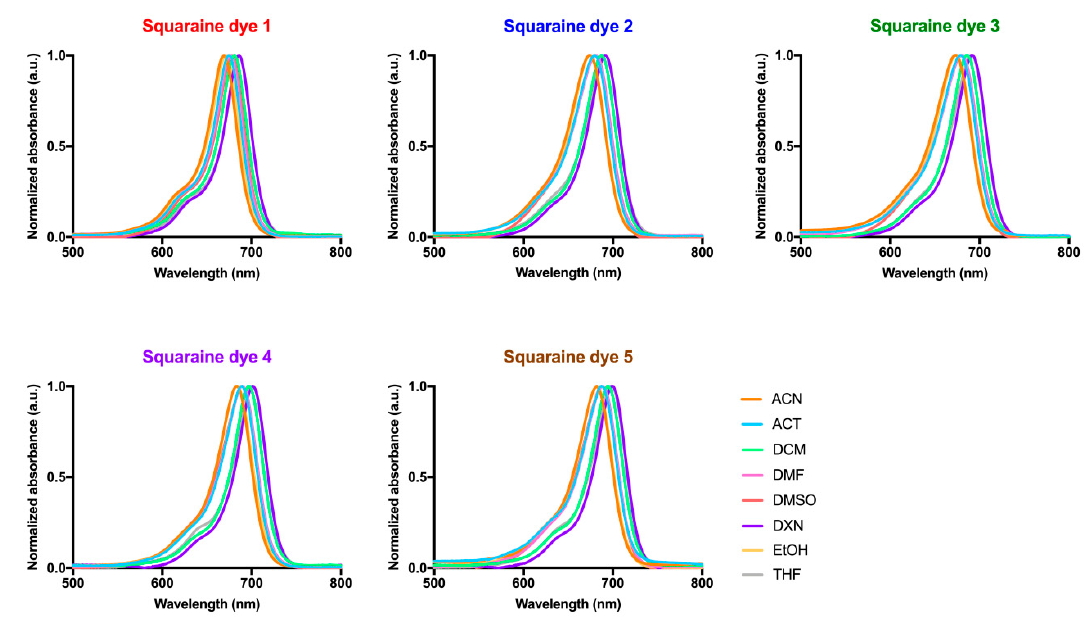
Figure 4. Absorption spectra of dicyanomethylene squaraine dyes ( 1 – 5 ) in acetonitrile (ACN), acetone (ACT), dichloromethane (DCM), dimethylformamide (DMF), dimethyl sulfoxide (DMSO), 1,4-dioxane (DXN), ethanol (EtOH) and tetrahydrofuran (THF). The absorbance was normalized and is presented as arbitrary units (a.u.).